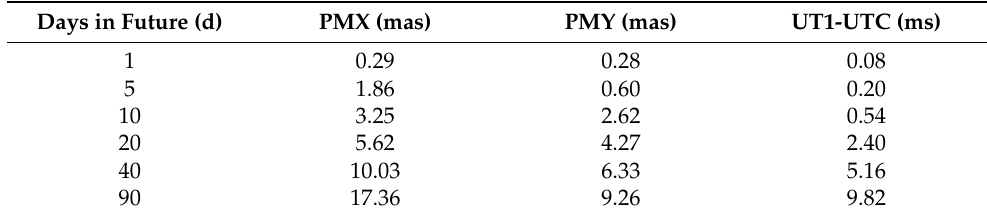
Table 1. ERP prediction accuracy in various